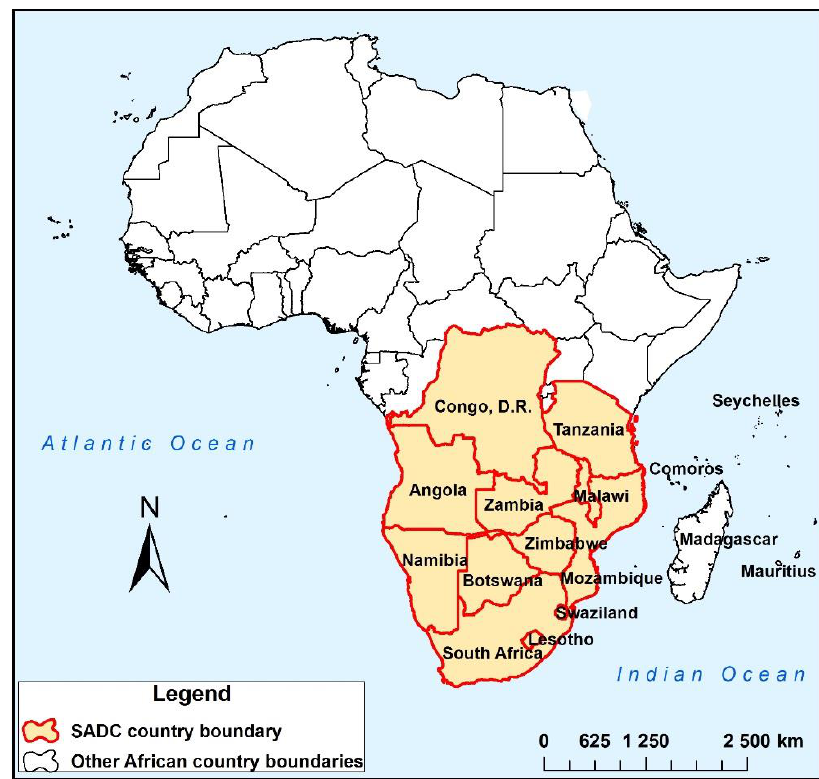
Figure 1. Location of Southern African Development Community (SADC) countries in Africa. Source: Developed by the authors. Note: Madagascar, Mauritius, Seychelles and Comoros are part of the SADC, but are not highlighted in colour as the study is focussing on mainland southern Africa.